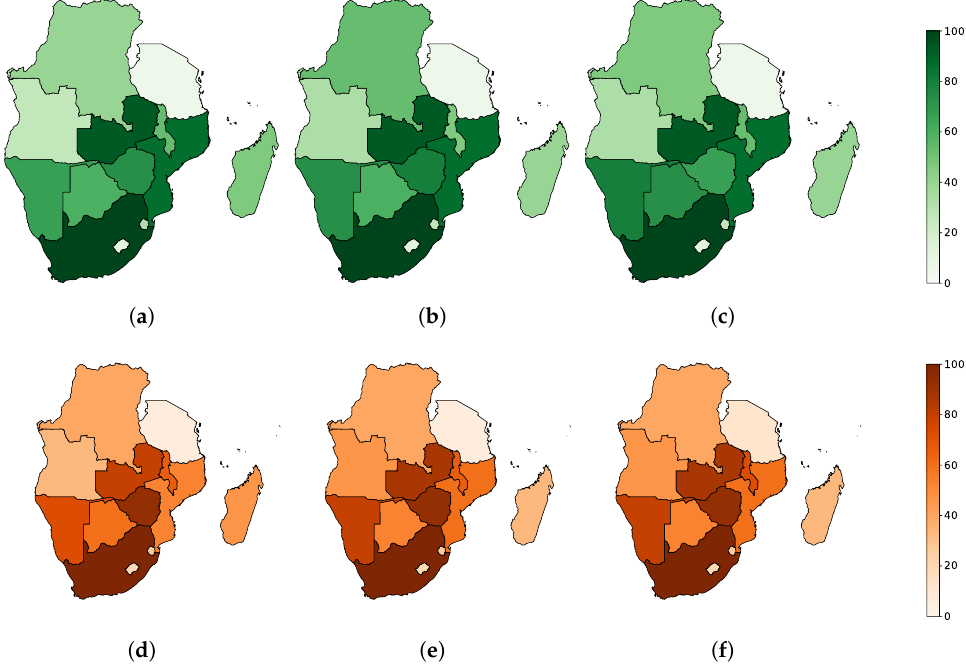
Figure 9. MES-LSTM Prediction Interval Accuracy (normalized MIS) Ranked for Each Country in the SADC Region. ( a ) total cases ( α = 0.05). ( b ) total cases ( α = 0.1). ( c ) total cases ( α = 0.2). ( d ) total deaths ( α = 0.05). ( e ) total deaths ( α = 0.1). ( f ) total deaths ( α = 0.2).